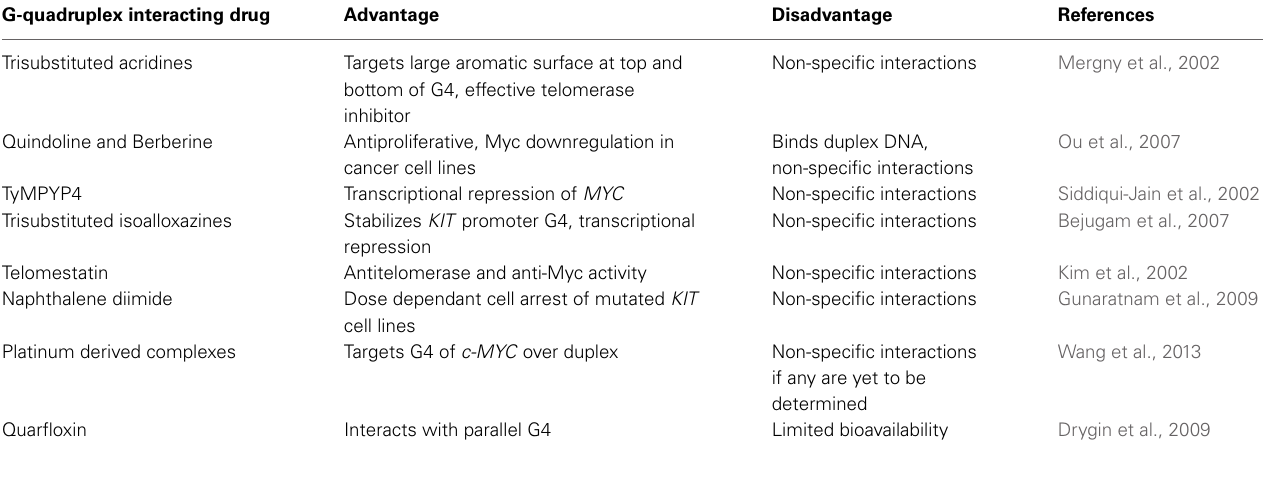
Table 1 | List of G4 binding anticancer drugs tested. G-quadruplex interacting